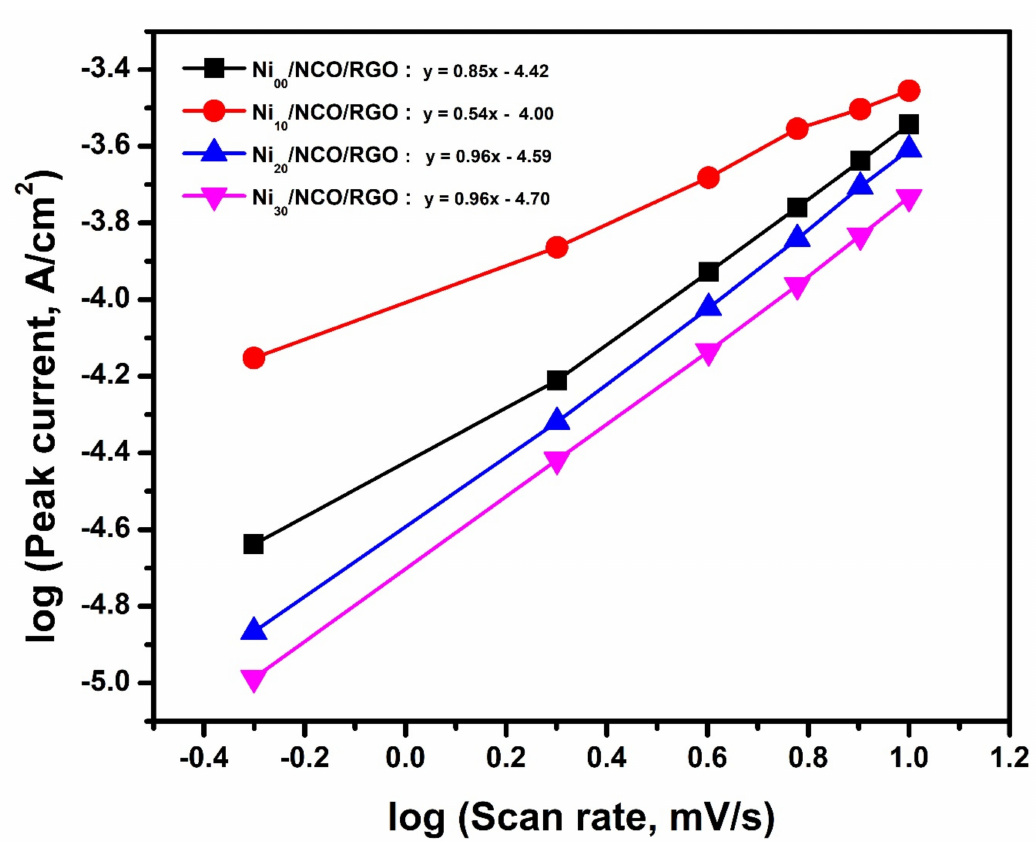
Figure 8. Dependence of the peak current on the scan rate ( υ ) for various Ni/NCO/RGO